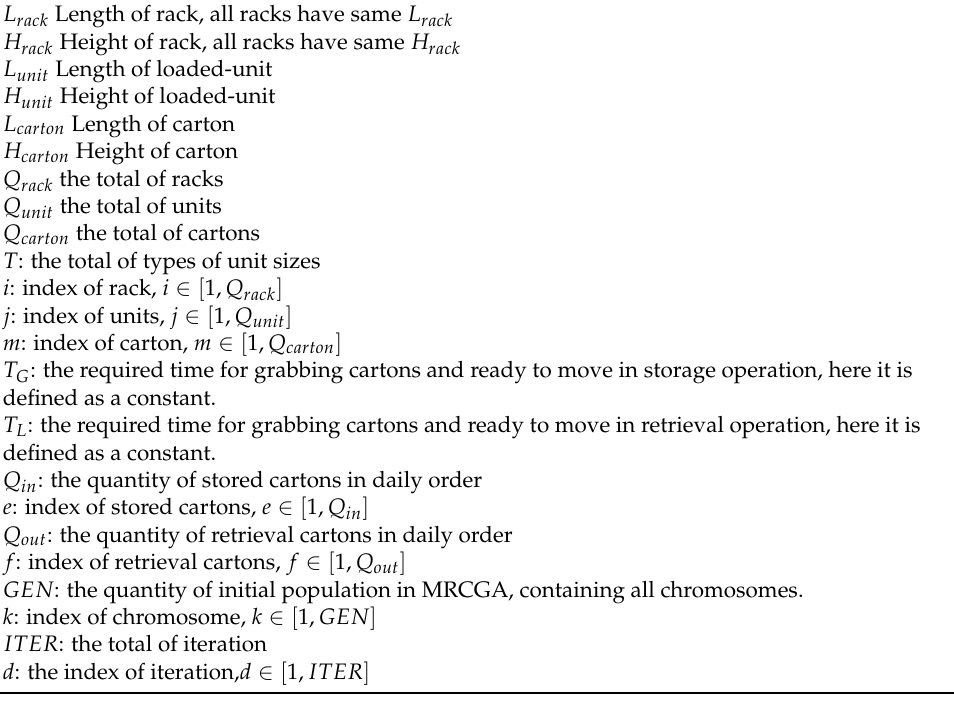
Table 2 summarizes the definitions of parameters and variables used in this paper. Table 2. Table of